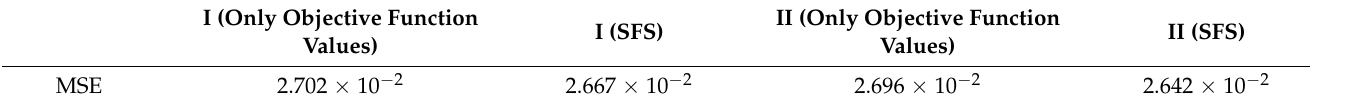
Table 8. MSE results of machine learning to small-scale problems for 3 objectives.